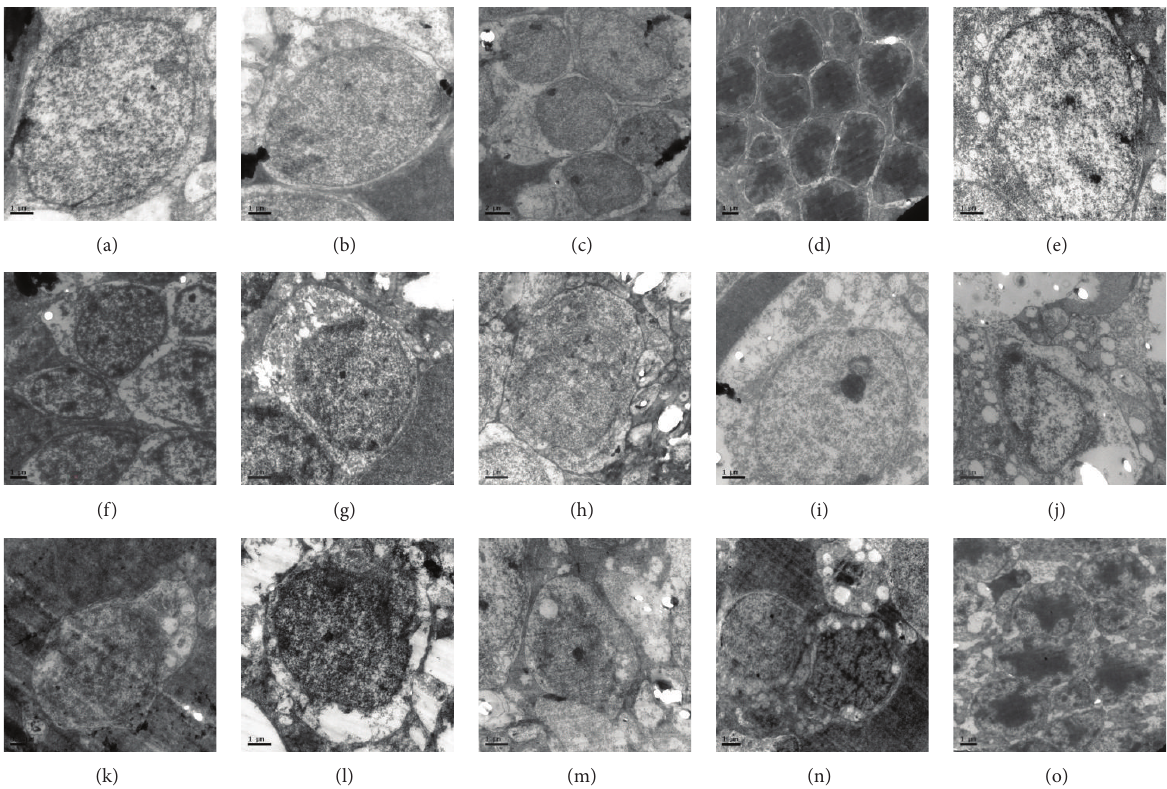
Figure 2: The ultrastructure of retina under electron microscope. (a–d) Control group; (e–h) diabetic group at week 4; (i–k) diabetic group at week 8; (l–o) diabetic group at week 12. In control group, RGC (a × 15K); INL (b × 15K), (c × 8000); ONL (d × 10K). In diabetic group at week 4, RGC (e × 15K); INL (f × 15K), (g × 15K), and (h × 15K). In diabetic group at week 8, RGC (i × 15K), (j × 15K); INL (k × 15K). In diabetic group at week 12, RGC (l × 15K), (m × 15K); INL (n × 15K); ONL (o ×